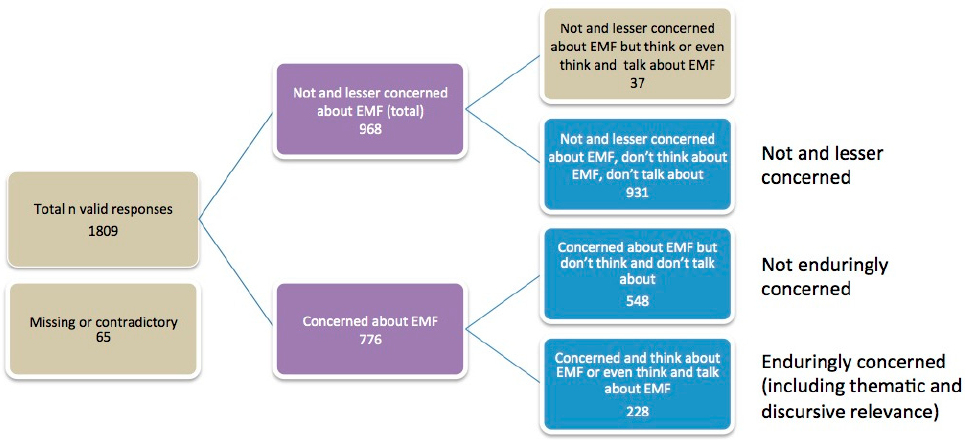
Figure 1. Distribution tree of the study participants regarding electromagnetic field (EMF) risk perception in terms of concern, thematic and discursive relevance. In each box, the number of included subjects is given.